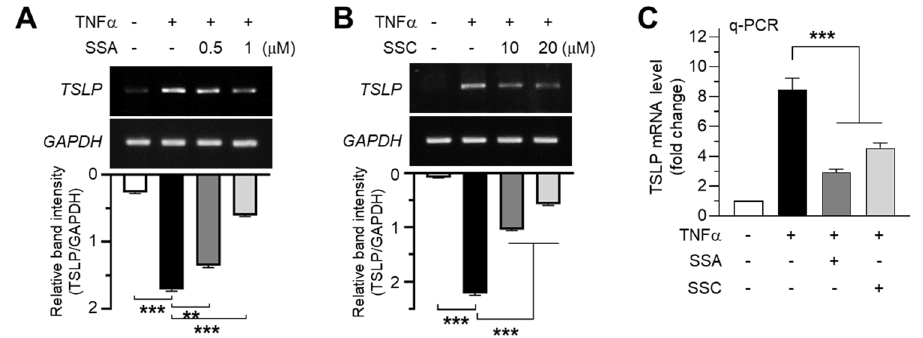
Figure 2. Inhibitory effects of SSA and SSC on TNF- α -induced TSLP expression in HaCaT cells. ( A , B ) HaCaT cells were pretreated with 0.5 or 1 µ M SSA ( A ) and 10 or 20 µ M SSC ( B ) for 30 min before treatment with 10 ng/mL of TNF- α . After 12 h, TSLP mRNA levels were measured using reverse transcription-PCR. The band intensities corresponding to TSLP levels were normalized to those of GAPDH levels using ImageJ software. ( C ) HaCaT cells were treated with 10 ng/mL of TNF- α for 12 h in the absence or presence of 1 µ M SSA or 20 µ M SSC, and quantitative real-time PCR was performed. Data are expressed as means ± SD ( n = 3). ** p < 0.01, *** p < 0.001 by Dunnett’s multiple comparisons